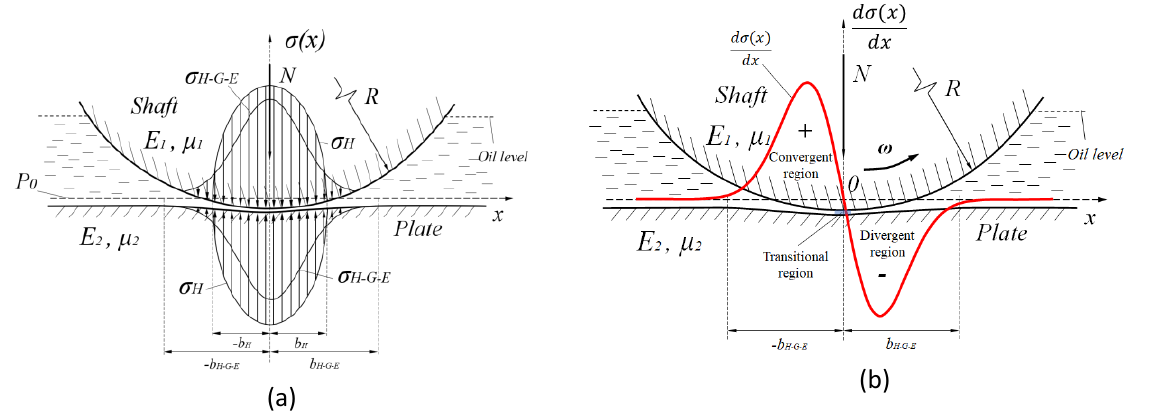
Fig. 7. Scheme of the formation of an elastically deformed linear contact of the shaft surface with a flat model bearing under static compression (without friction) with adsorbed layers of lubricant in the form of a fillet, as well as diagrams of contact stresses in the form of a semi-ellipse according to Hertz H x and in the proposed by the authors exponential distribution of Hertz-Gauss-Euler H G E x relative to the ambient pressure